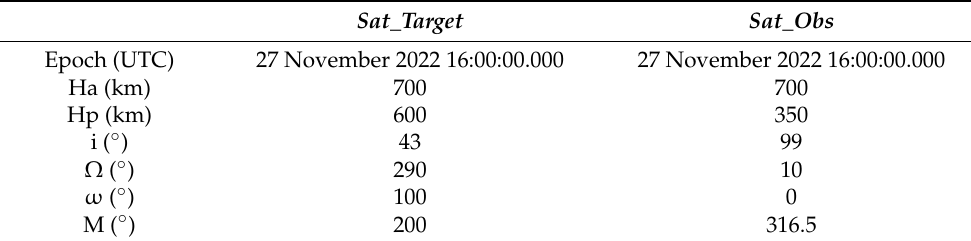
Table 1. Initial calculation conditions.